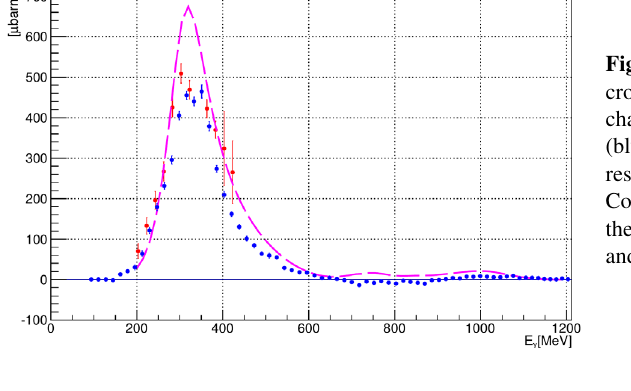
Figure 1. Helicity dependent total cross section for the semi-exclusive (cid:7)γ(cid:7) d → π 0 X . The A2 results channel (blue circles) are compared with the results from the GDH Collaboration (red circles) and with the sum of MAID for free proton and neutron (dashed magenta line).